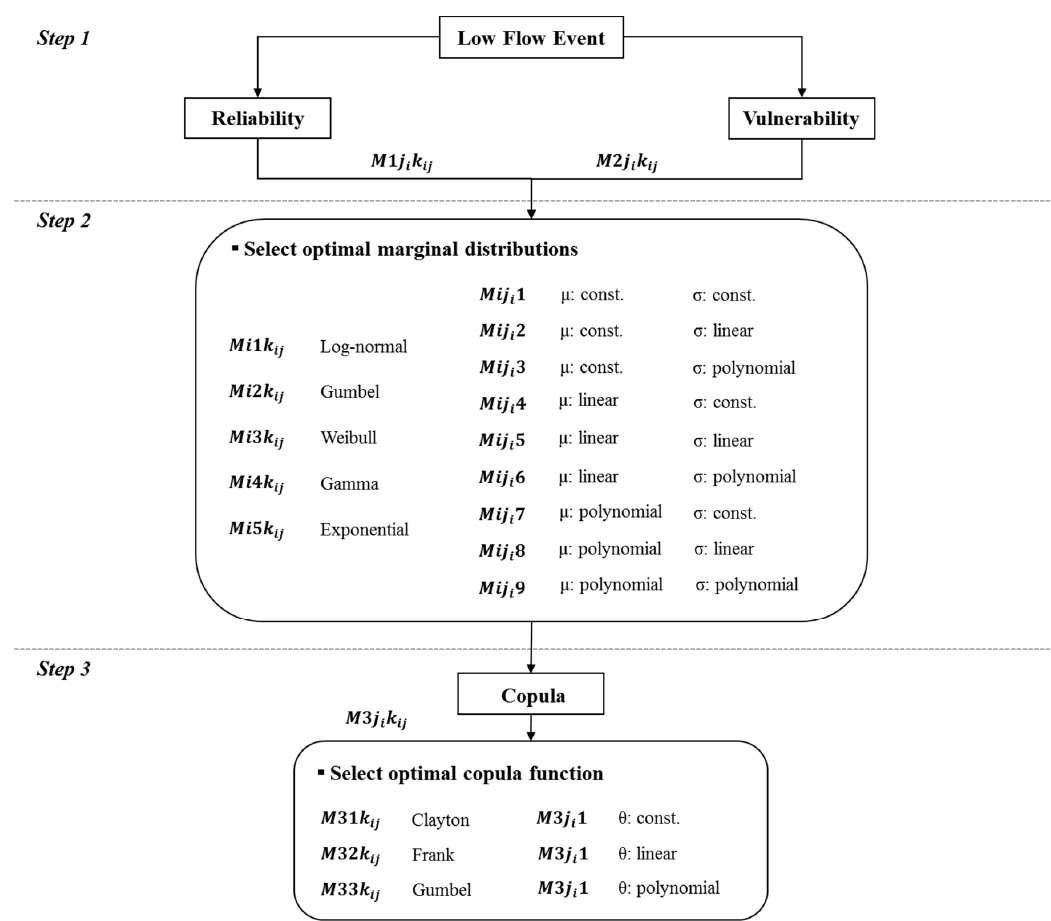
Figure 2. The time-dependent copula modeling procedure and model description.